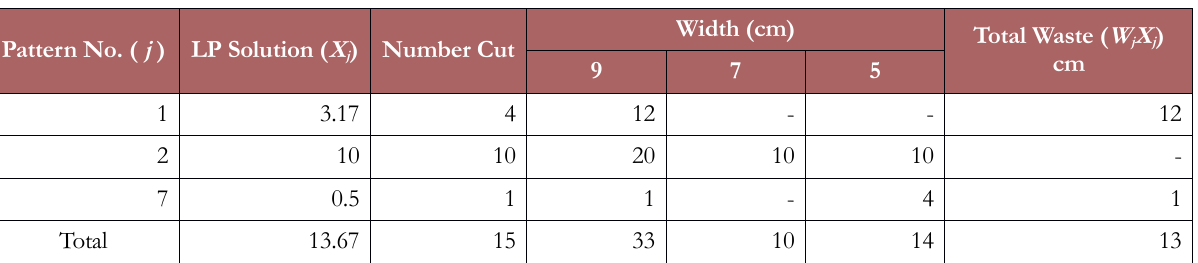
Table 8. Total number of planks to be used for Case II Product I (Conference Chairs)